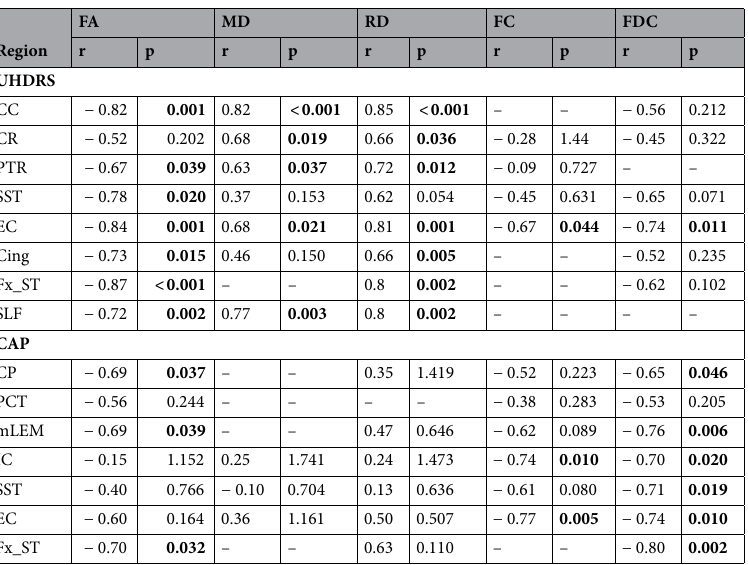
Table 1. Correlation of DTI and FBA metrics to clinical scores. Dashes (–) represent regions that were not selected since they showed no differences between patients and controls. CC: corpus callosum, CR: corona radiate, PTR: posterior thalamic radiation, SST: sagittal stratum, EC: external capsule, Cing: cingulum, Fx_ST: fornix/stria terminalis, SLF: superior longitudinal fasciculus, CP: cerebellar peduncle, PCT: pontine crossing tract, mLEM: medial lemniscus, IC: internal capsule. P values have been corrected for multiple comparisons using the holm-bonferroni step-down